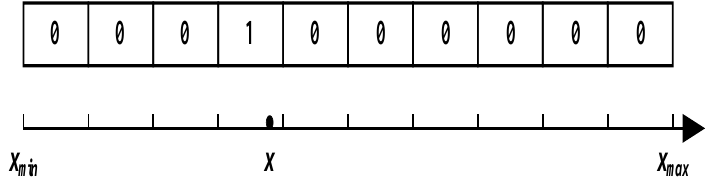
Figure 12. One-hot processing of a statistical feature.